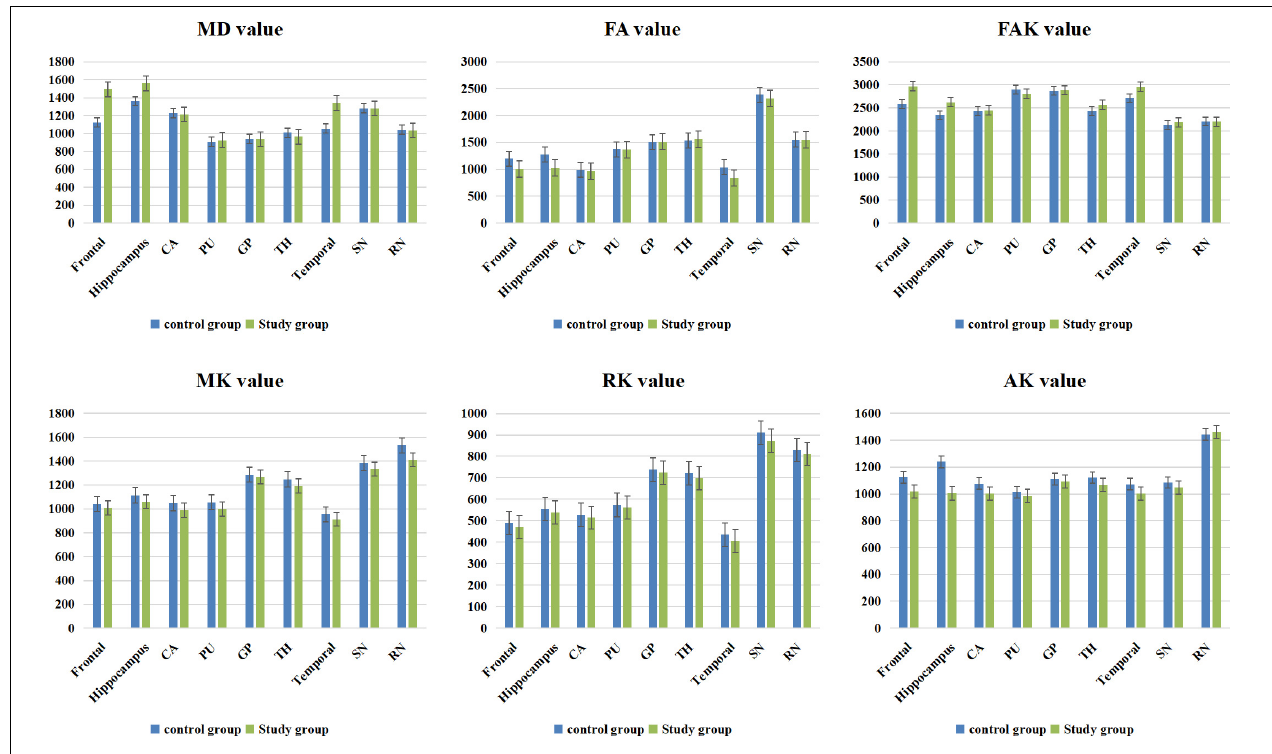
FIGURE 3 | Diffusion kurtosis imaging (DKI) value bar graphs.